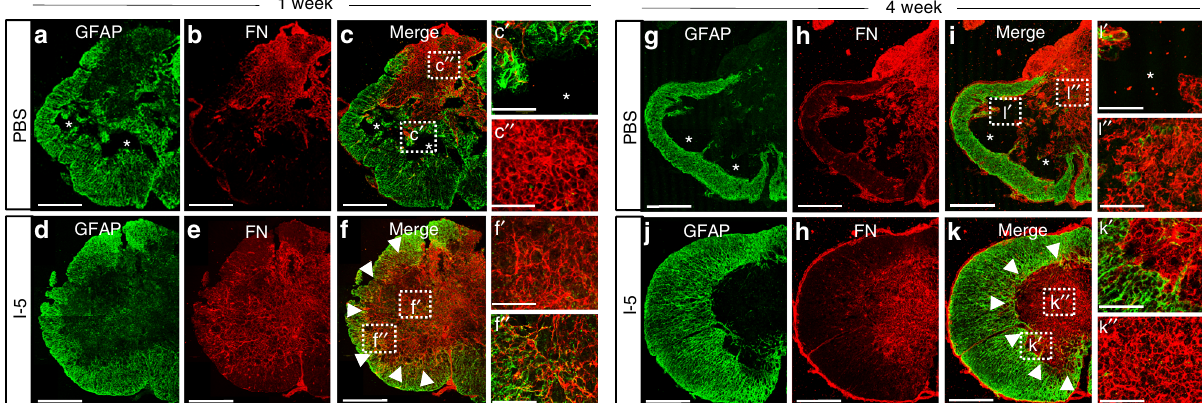
Fig. 4 Remodeling of extracellular matrix by I-5 injection. a – f Representative images of transverse spinal cord sections obtained at 1 week after injection from animals with PBS ( a – c ) or I-5 ( d – f ) injection. Arrowheads indicate the border between the GFAP- and FN-positive areas. Boxed regions in c , f were magni fi ed in c ʹ , c ″ , f ʹ , f ″ . c ʹ Early cavity space (*) surrounded by GFAP-immunoreactive astroglial cells. c ″ FN-rich extracellular matrix ( ECM ). f ʹ FN-rich ECM. f ″ GFAP and FN immunoreactivity intermingled in the border region. g – k Representative images of transverse spinal cord sections obtained 4 weeks after injection from animals with PBS ( g – i ) or I-5 (j – k) injection. Arrowheads indicate the border between the FN and GFAP immunoreactivities. Boxed regions in i , k were magni fi ed in i ʹ , i ″ , k ʹ , k ″ . i ʹ A cystic space (*) with residual FN-immunoreactive matrix. i ″ FN-rich ECM at the periphery of the lesion center. k ʹ The sharp boundary between the FN- and GFAP-positive areas. k ″ Formation of dense and strong FN-rich matrix in the center of the lesion. All asterisks indicate cystic cavities. Scale bars represent 500 μ m in a – k . Scale bars in the magni fi ed images represent 100 μ